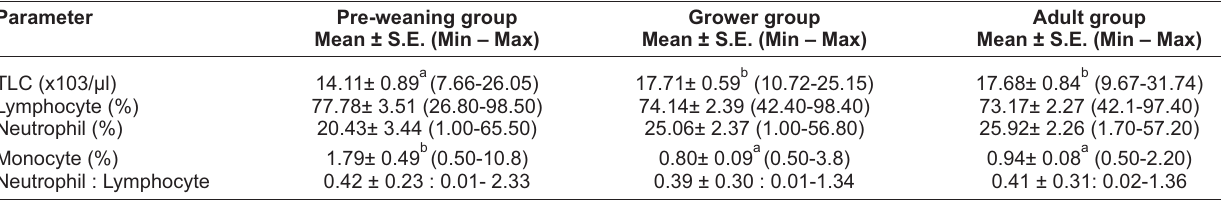
Table-2: Effect of age on leukocyte picture of Zovawk pigs